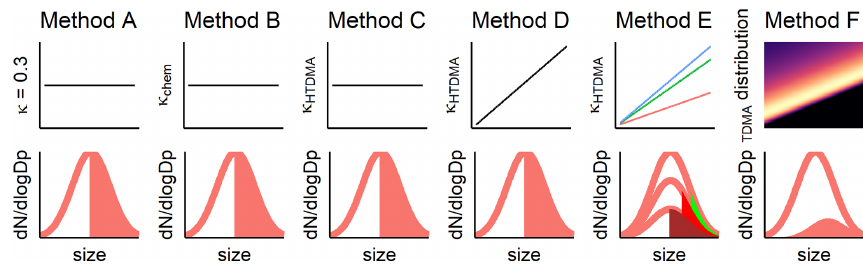
Figure 1. Schematic illustration of different methods used for N CCN estimation. Method A: constant κ of 0.3; method B: size-independent κ derived by bulk PM 1 chemical composition; method C: size-independent κ derived by hygroscopicity growth factor (GF) at 165nm; method D: size-dependent κ derived by hygroscopicity growth factor; method E: size-independent κ and number fractions of near-hydrophobic, more-hygroscopic and sea-salt modes; method F: size-dependent activation ratio based on GF probability density function (GF–PDF). Table 3. The simplification and assumption of N CCN and the median relative error estimation